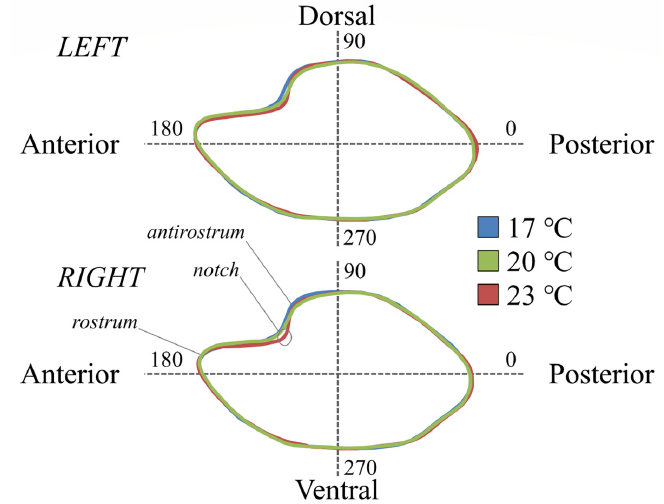
Figure 4. Average otolith shape configurations of seabream metamorphosing larvae (56–58 days post-hatching, dph) demonstrate the main shape differences between thermal groups; 17, 20, and 23: fish initially reared at 17, 20, and 23 ◦ C DT (developmental temperature), respectively.